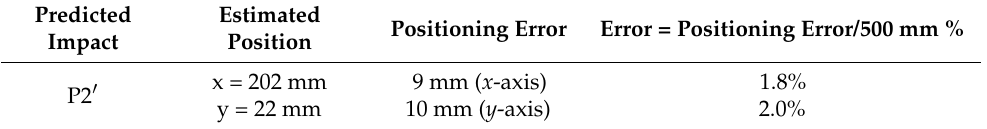
Table 3. Estimated impact position obtained for impact P2 (cid:48) with coordinates x i = 193 mm, y i = 32 mm. Predicted Impact